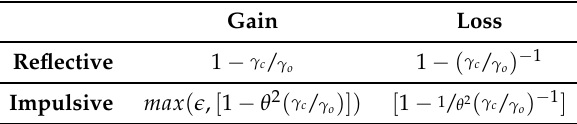
Table 1. Threshold